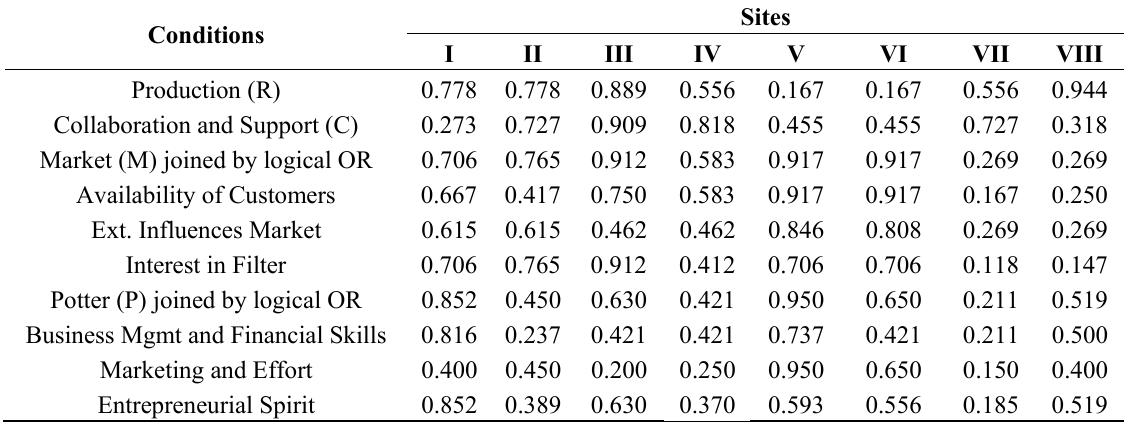
Table 4. Fuzzy-set scores for each site of four combined conditions and six